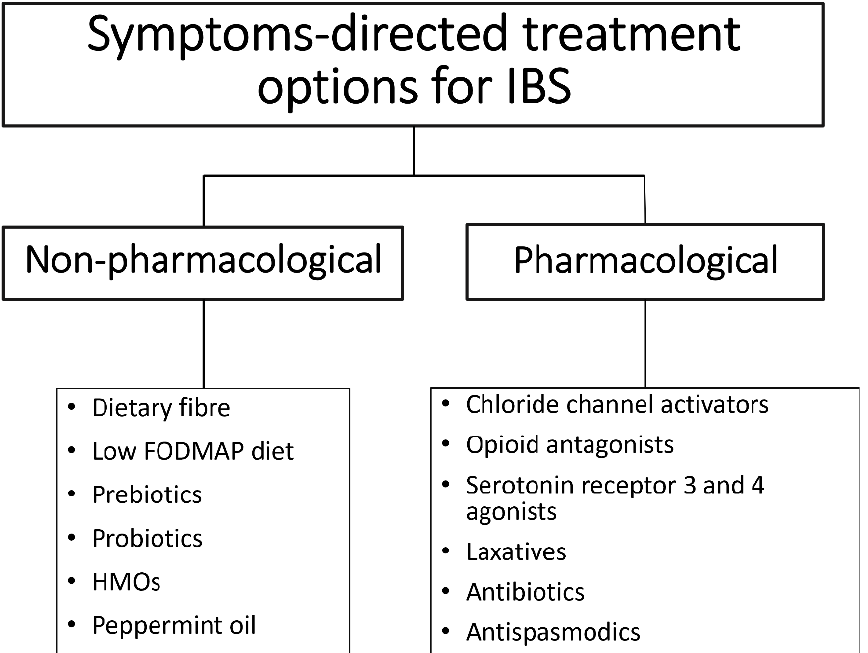
Figure 2. Treatment options for IBS are based on symptoms and may be pharmacological or non- pharmacological.